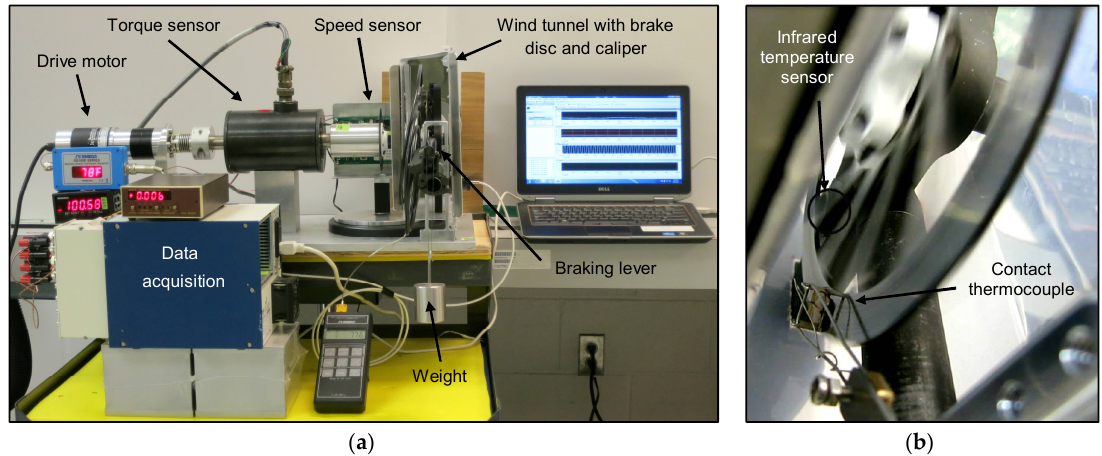
Figure 1. Brake dynamometer experimental setup: ( a ) Overall setup and data collection equipment; ( b ) Photograph looking into the wind tunnel inlet with disc in motion, showing the temperature sensor